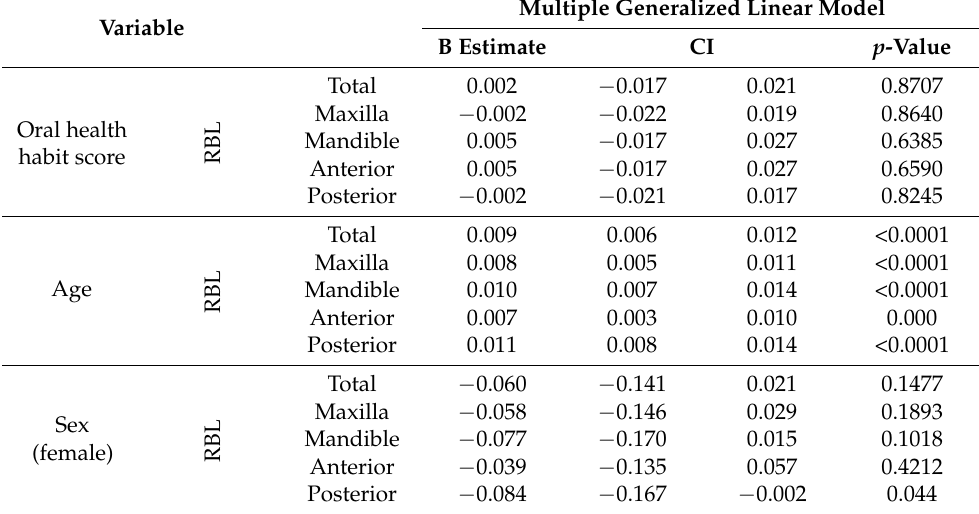
Table 4. The multiple generalized linear model estimate between the RBL adjusted by oral health habit score, age and sex.